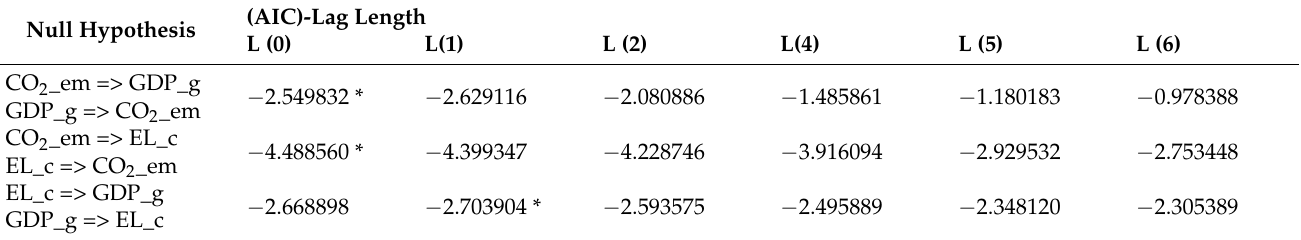
Table 9. Selection of Optimal Lag Length for test of Granger Causality based on